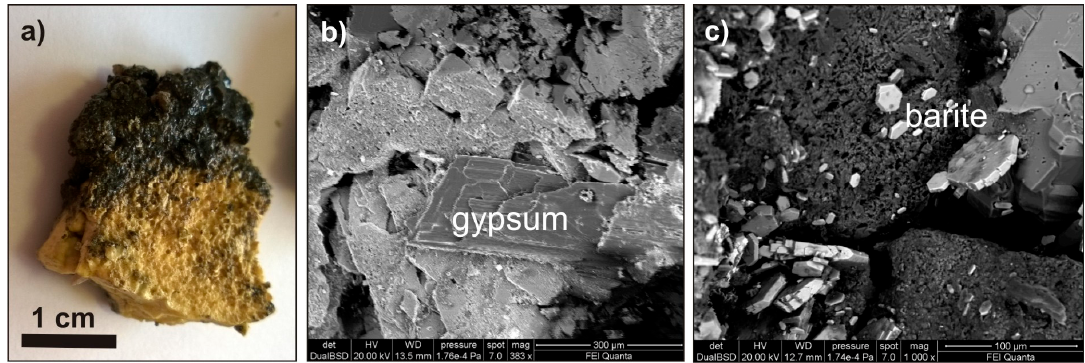
Figure 10. ( a ) macroscopic rock image of ST2BNR3 sulfur crust including ( b ) gypsum, and ( c ) barite.